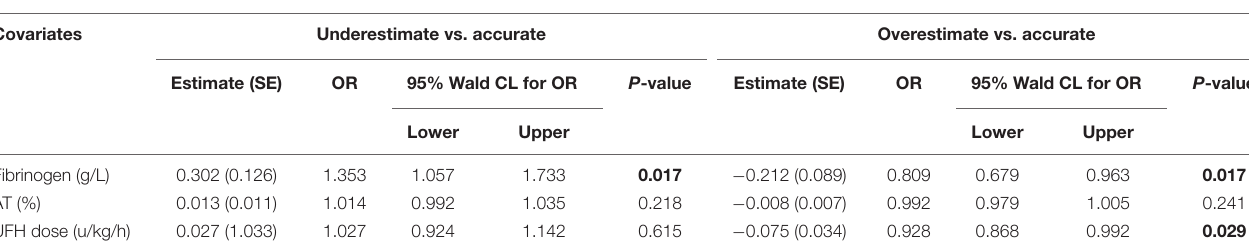
TABLE 3 | Multinomial logistic regression analysis for bias categories. Covariates Underestimate vs. accurate Overestimate vs.